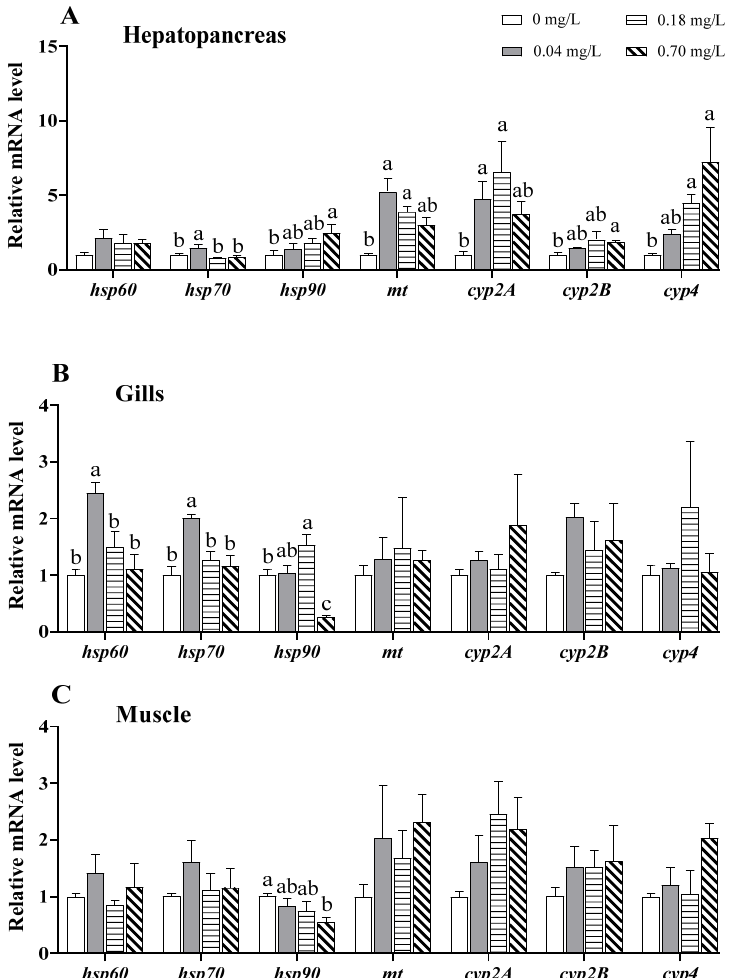
Figure 8. Expression of stress- and detoxification-related genes in different tissues of E. sinensis exposed to copper for 5 days. ( A ) Hepatopancreas; ( B ) gills; ( C ) muscle. The values are expressed as the mean ± SEM ( n = 6). Different letters denote significant differences among different groups ( p < 0.05).